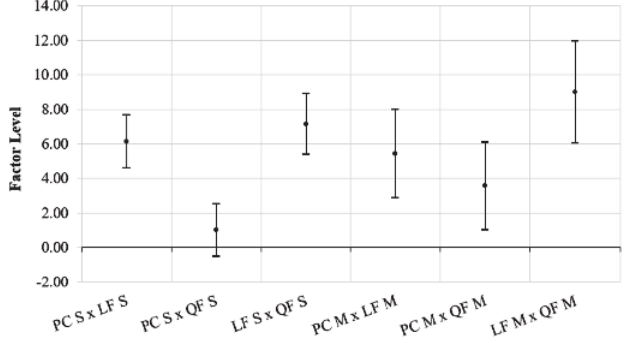
Comparison between averages of flexural tensile strength losses (tukey test for a significance level of 5%) of the same series for different aggressive solutions (S - sodium sulfate and M - magnesium sulfate) for 20 weeks of exposure